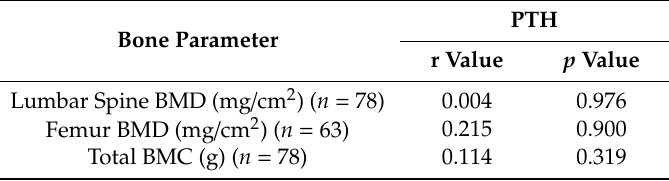
Table 9. Correlations between PTH concentrations and lumbar spine and femur bone densitometry assessed by DXA of Brazilian women living in Brazil ( n = 78) 1